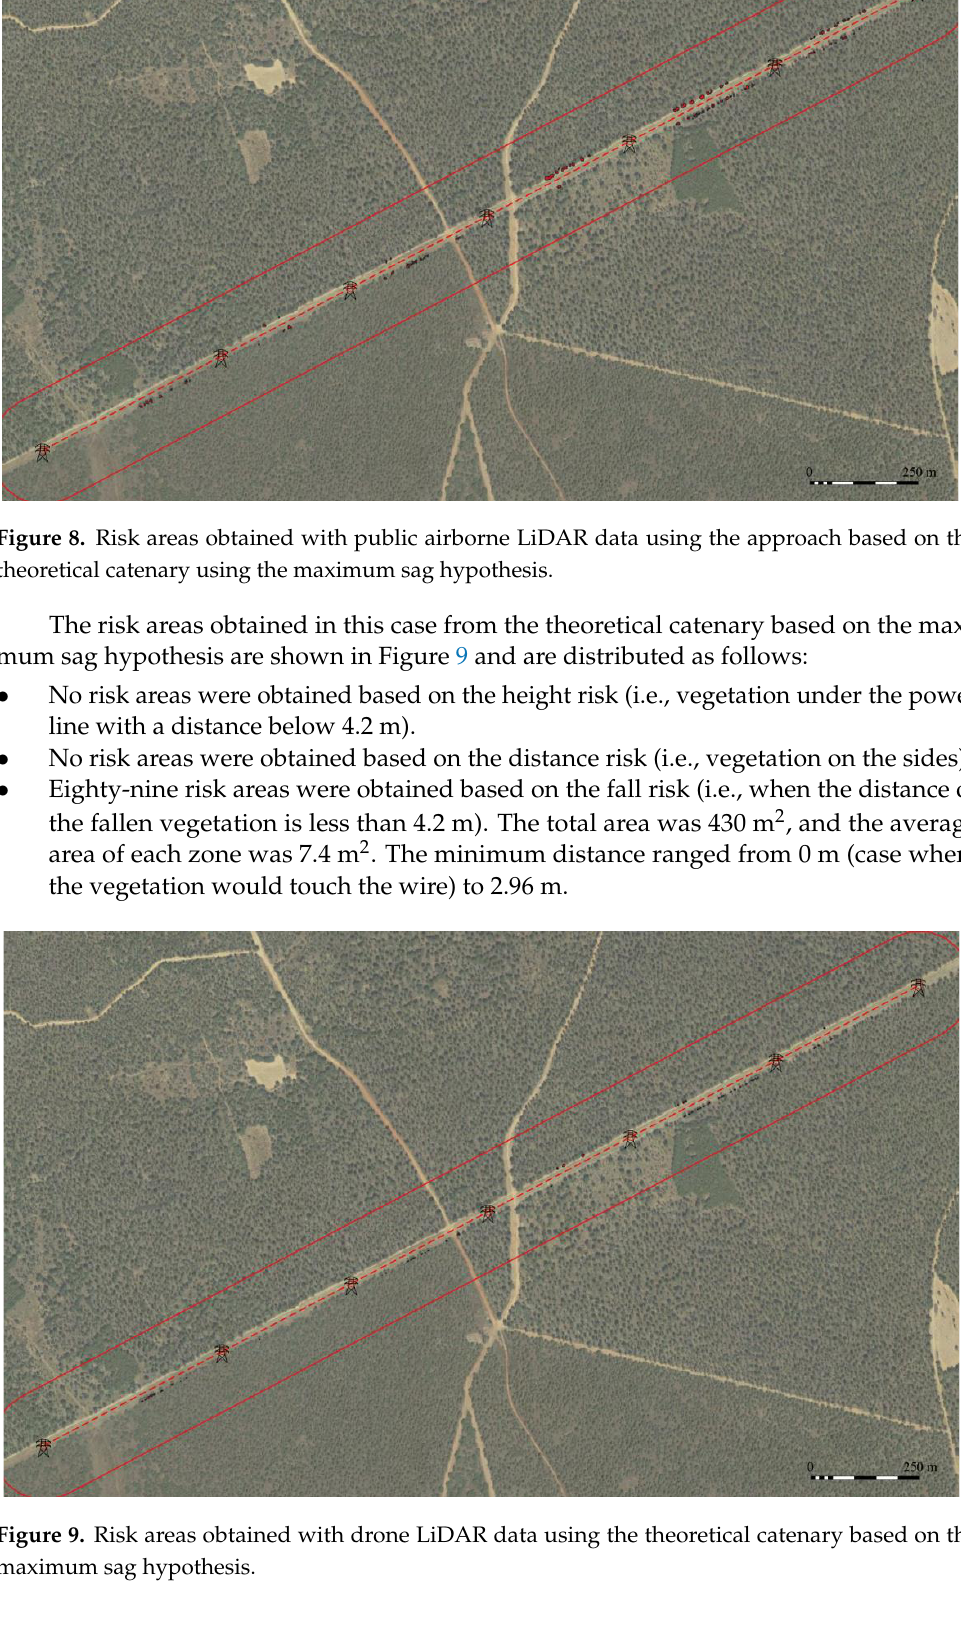
Figure 10. Risk areas obtained with drone LiDAR data from the estimation of wire groups using the point cloud. 3.4. Discussion To analyse the differences between the two methods and to verify the validity of the calculations made with the public airborne LiDAR data, a summary and comparison of the results is shown in Table 3.